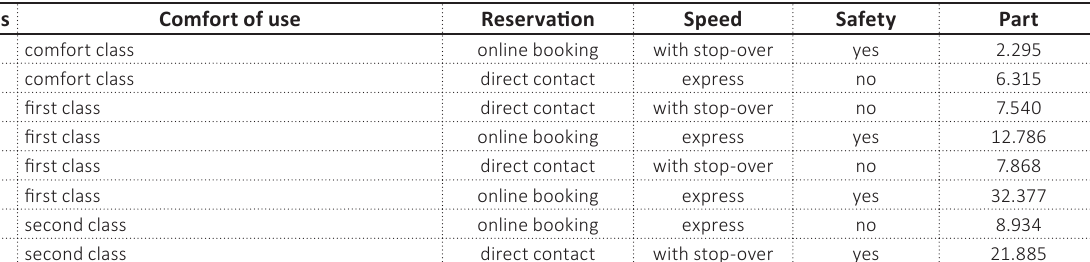
Table 7. Part of the